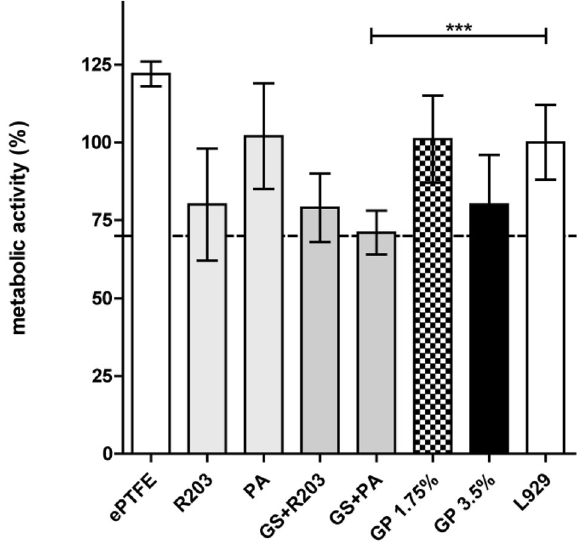
Fig. 6 Metabolic activity of murine fi broblasts (L929) using a WST-1 assay. L929 were challenged with the DMEM elution of untreated, non-gentamicin and gentamicin-coated ePTFE grafts respectively ( n = 7). Dotted line indicates the limit of tolerated loss of activity at 70% according to the ISO 10993-5 standard for medical devices